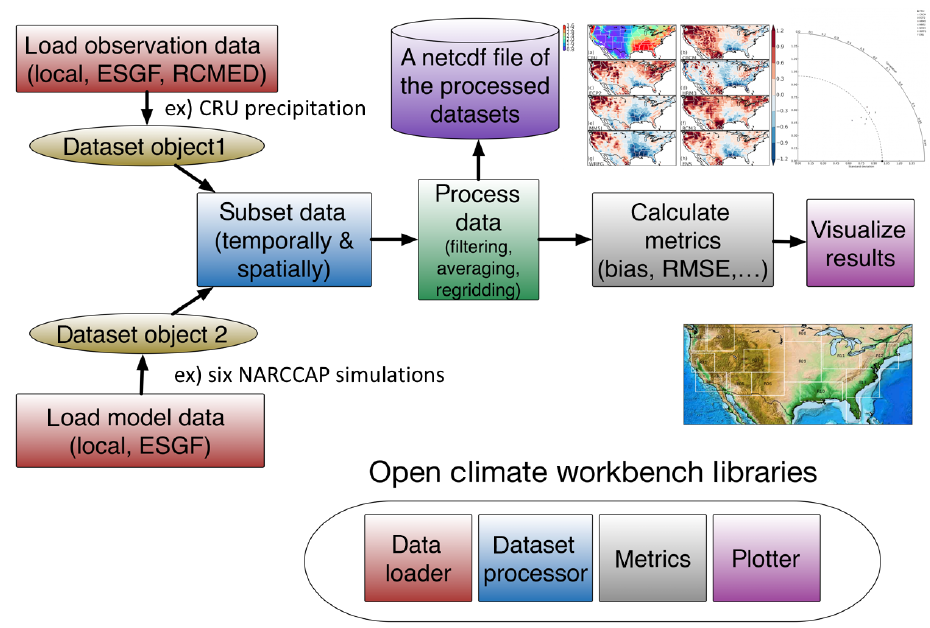
Figure 4. The process of evaluating climate models using datasets from multiple sources and modularized OCW libraries. The evaluation metrics and plots in Kim et al. (2013) are shown as an